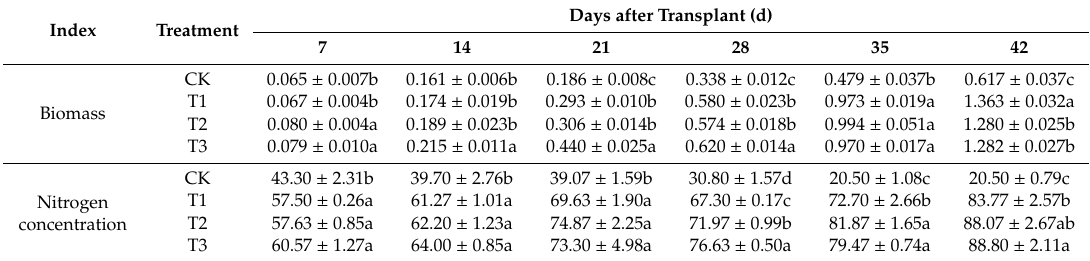
Table 3. Accumulation of dry weight (g · plant − 1 ) and nitrogen concentration (g · kg − 1 DW) in shoot.